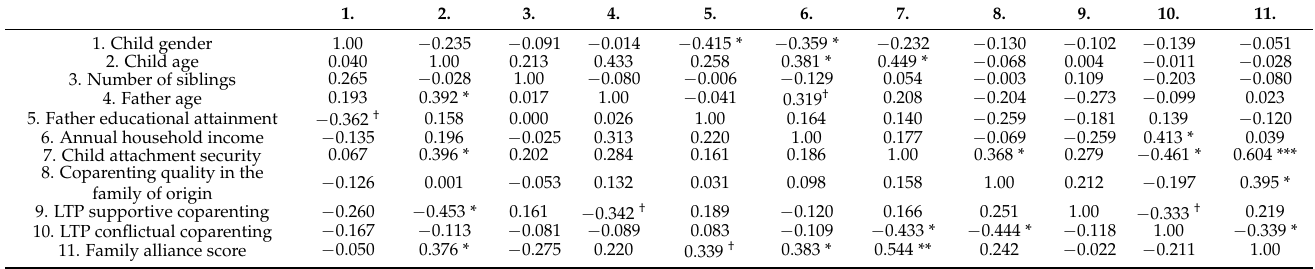
Table 2. Associations between children’s and fathers’ demographic factors, child attachment security, coparenting quality in fathers’ families of origin, observed coparenting, and observed family alliance, by family type ( N =